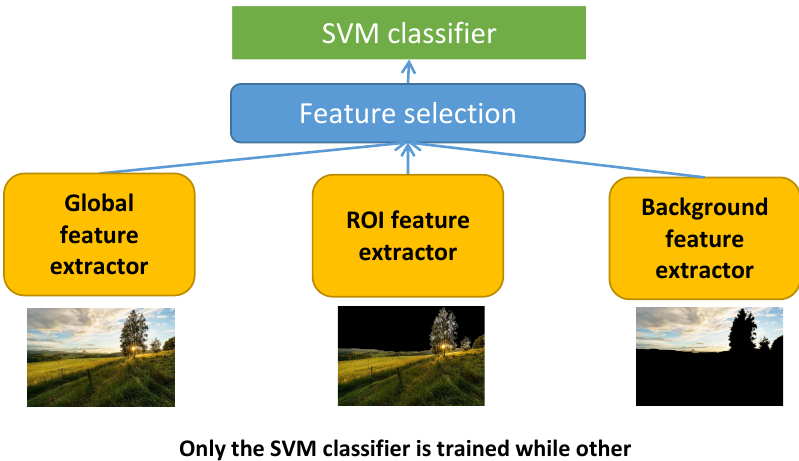
Figure 16. Models using transferred features for LIAA, CIAA and